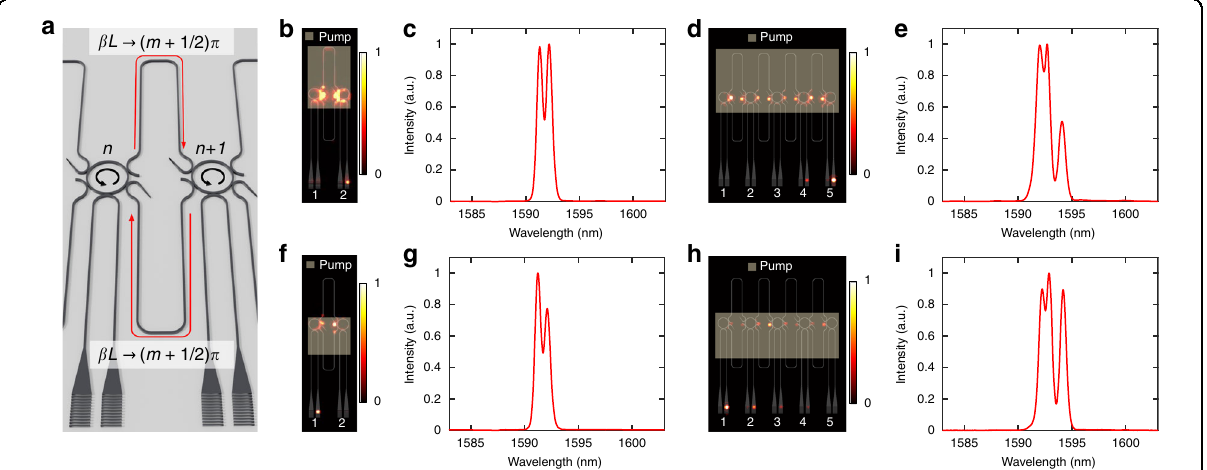
Fig. 4 Non-Hermitian skin effect in multi-mode laser arrays. a Schematic of the microring laser array where the length of the links is set to be central wavelength β L ! ð m þ 1 = 2 Þ π to observe multi-mode behavior. b , c , f , g Multi-mode lasing operation in 2-element Hatano – Nelson system with the aforementioned link phase condition. The output intensity (incoherent superposition of two modes) is tilted towards right end ( b , c ) and left end ( f , g ), respectively. d , e , h , i Multi-mode lasing behaviors in 5-element systems. The output intensity localizes at the right end ( d , e ) when the upper links are pumped, and left side ( h , i ) when the lower ones are illuminated. These results con fi rm that the non-Hermitian skin effect universally applies to all modes and their incoherent (intensity) superposition. The number of the data points in the spectra is